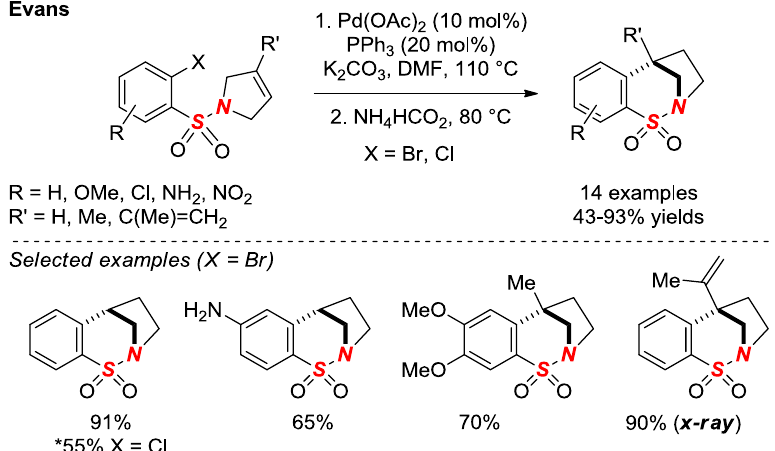
Figure 16. Synthesis of Saturated Bridged Sultams via Intramolecular Heck Reaction/Reduction.